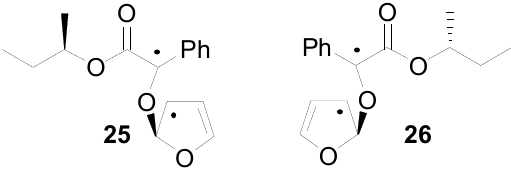
Figure 7. Radical intermediates in the reaction of chiral phenylglyoxylates with furan.